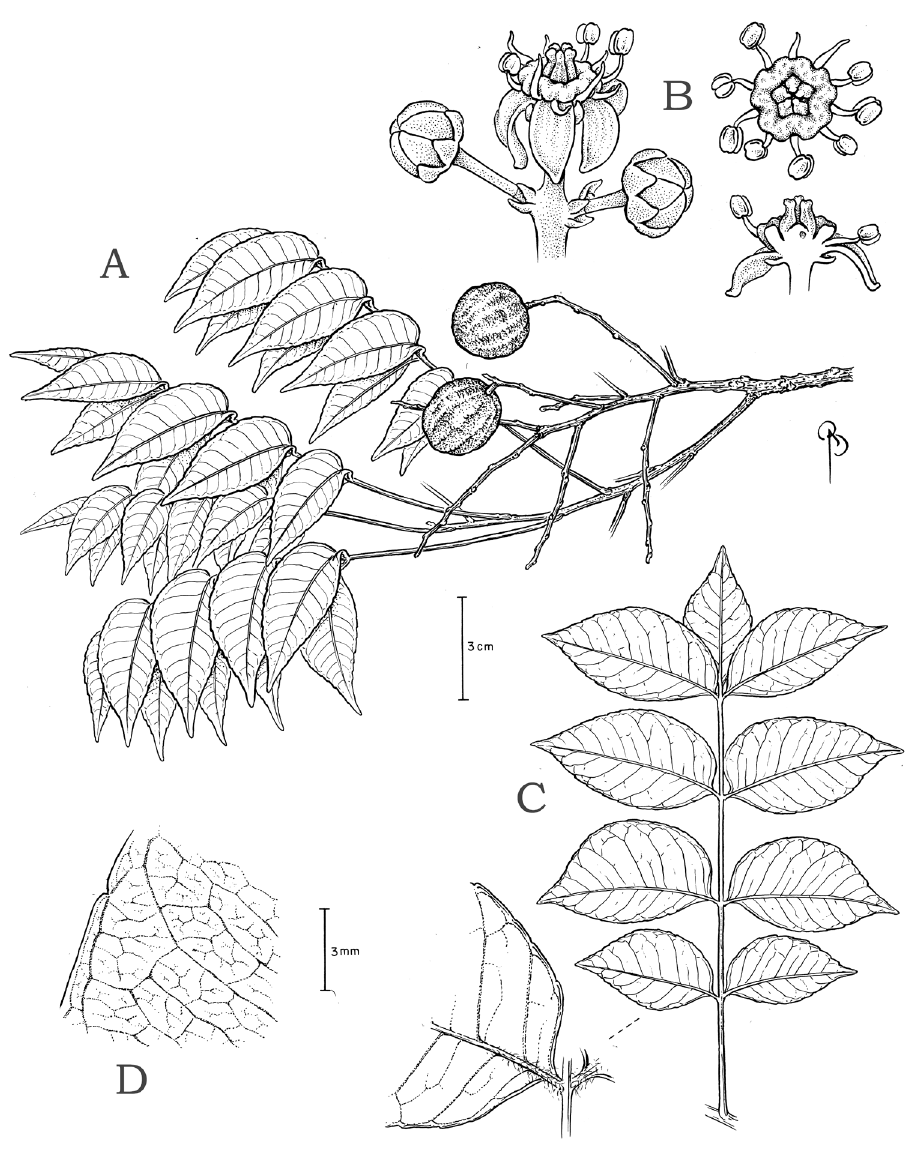
Figure 18. Spondias admirabilis. A Fruiting branchlet B Cymule with flower at anthesis (left); top view of stamens, disk, and immature pistil (right top); and longisection at center of flower with more of sta- mens removed C Whole leaf (right) and rachis plus leaflet bases (inset) D Leaf venation detail. A from Farney et al. 3957 (NY). B from Lanna Sobrinho 1587 (NY). C–D from Farney et al. 4172